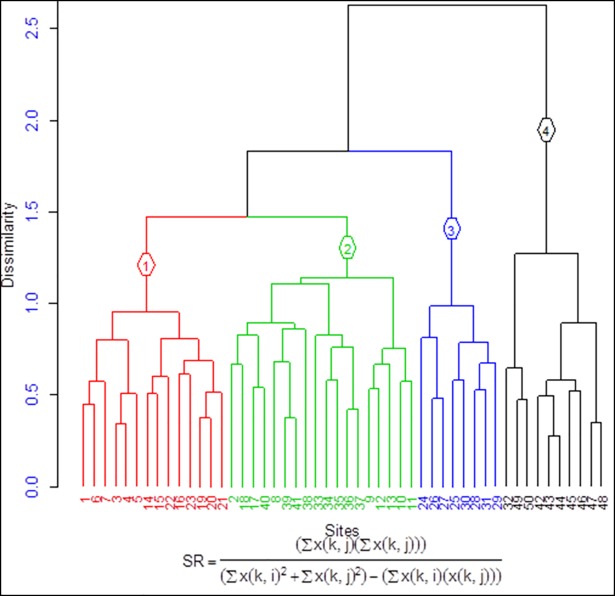
Dendrogram of hierarchical clustering using similarity ratio showing four community types in different sites (plot 1–50) of the study area (Ward's method, Euclidean distance).The vertical axis of the dendrogram represents the distance or dissimilarity between labeled clusters and the horizontal axis represents the sampled sitesclusteringinfour branches.